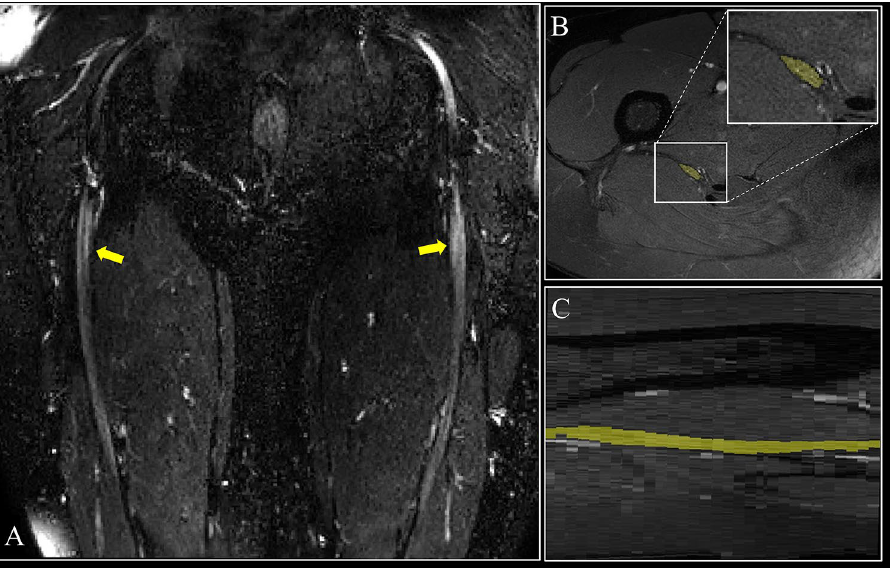
Figure 1. ( A ) Large field-of-view 3D SHINKEI image in the coronal plane showing the sciatic nerves (yellow arrows) in a healthy control; ( B ) Manual segmentation of the sciatic nerve slice-by-slice in the axial plane using the fat-suppressed T2-weighted acquisition (binary mask shown in yellow); ( C ) Segmentation of the sciatic nerve shown in the sagittal plane (binary mask shown in